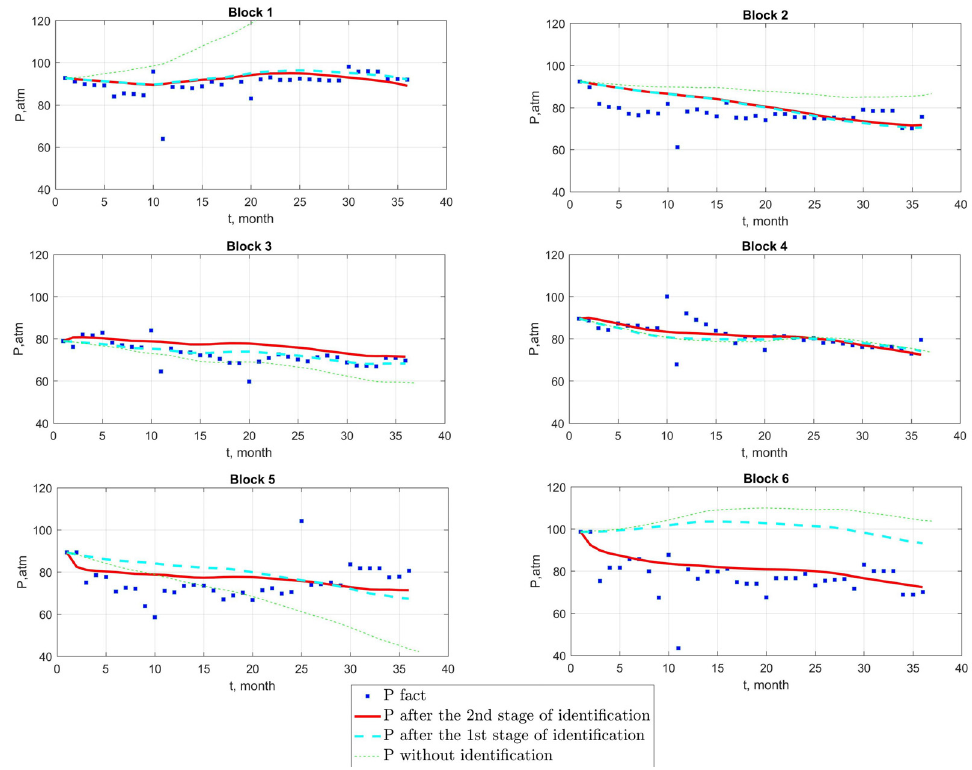
Figure 10. Comparison of actual and calculated reservoir pressures at each stage of identification for all oil field blocks.